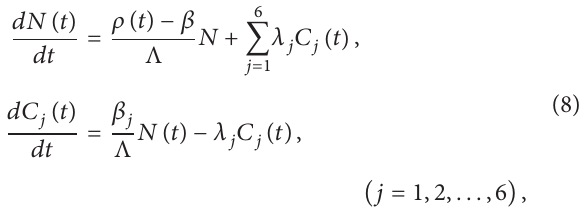
pumped into the primary heat exchanger where the water flows downward in the central pipe and then flows upward in tube side and absorbs heat from the primary coolant that flows downward in the shell